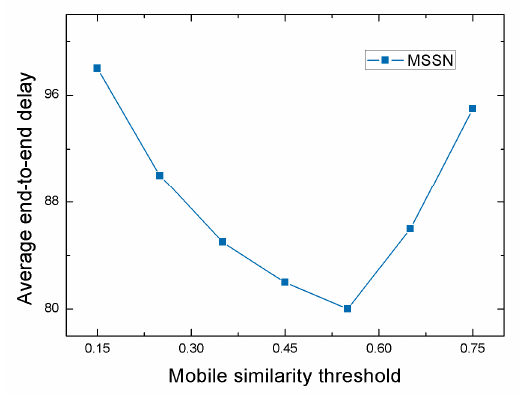
Figure 6. Average end-to-end delay with various mobile similarity threshold.